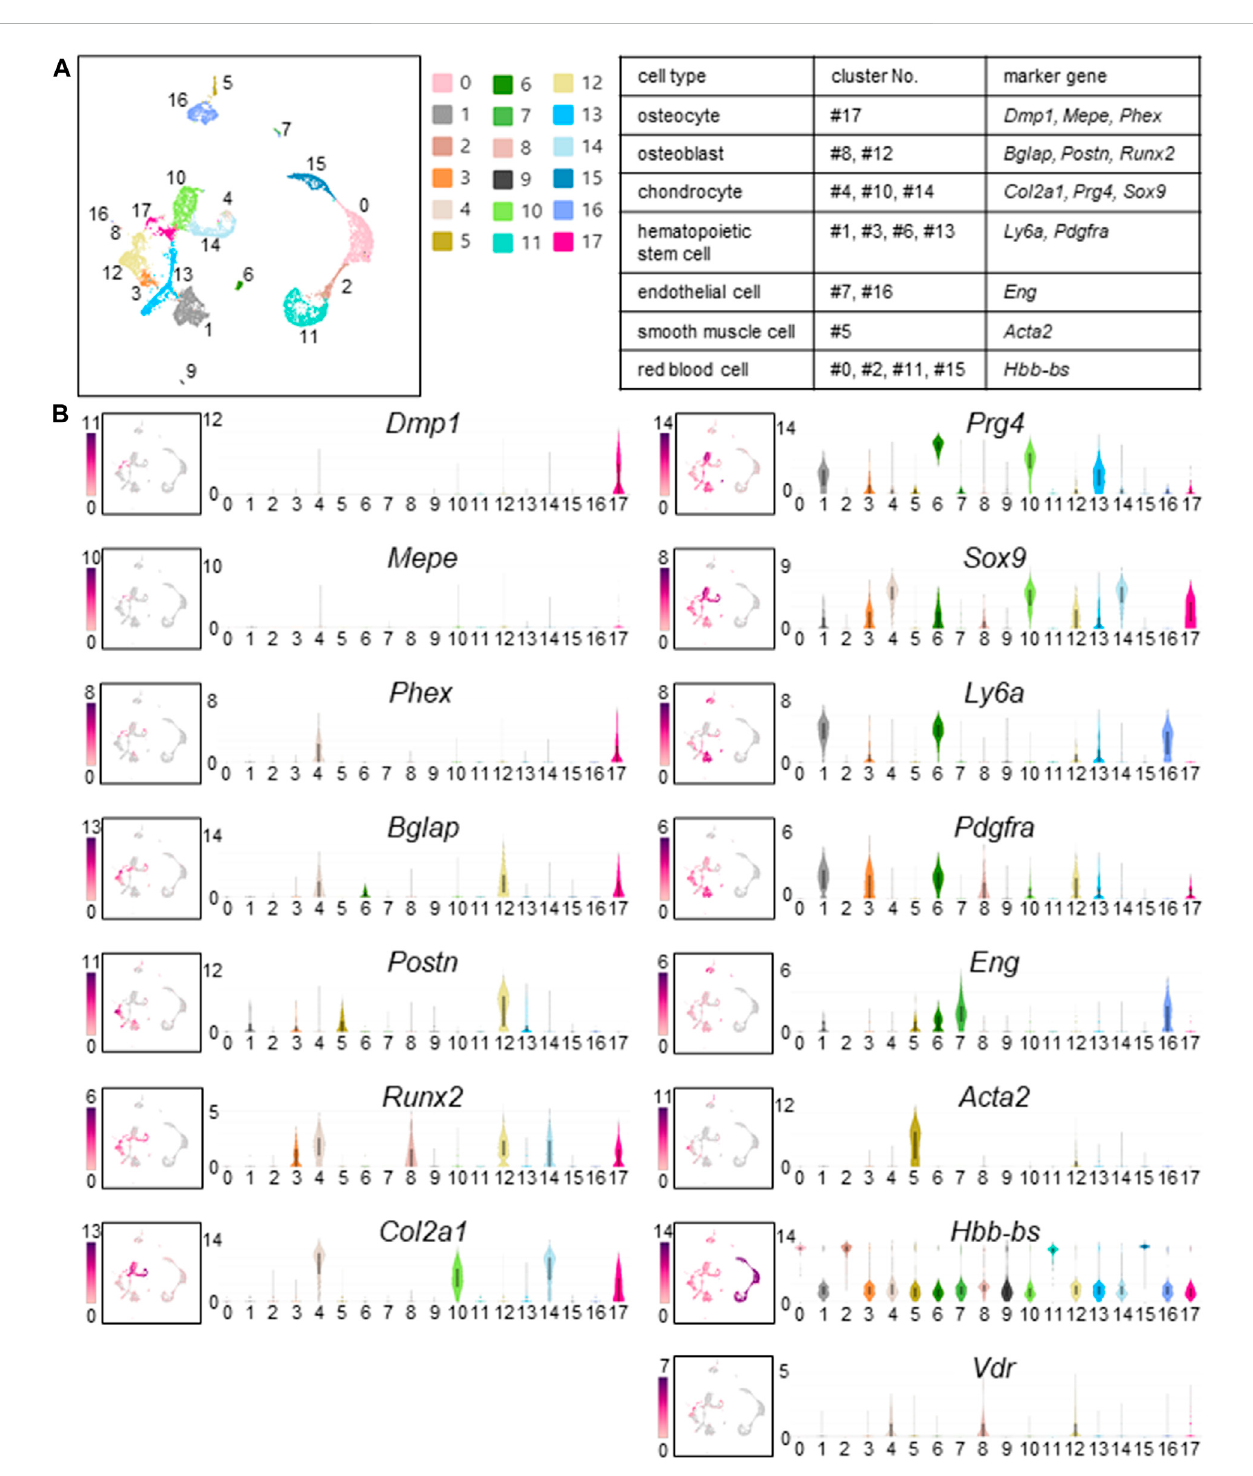
FIGURE 3 Cellclustersidenti fi edinfreshcellsisolatedfrommurinefemurs. (A) Cellclusteringwasperformedoncellsisolatedfromfemursofcalcitriol-injectedand untreated C57BL/6J mice. Uniform Manifold Approximation and Projection (UMAP) plot wherein each dot represents a single cell, and cells sharing the same color code indicate discrete populations of transcriptionally similar cells. Table shows the correspondence between cell type, cluster number, and marker gene when identi fi ed. (B) UMAP plots of gene expression (left) and associated violin plots (right) indicate cluster-speci fi c expression of representative genes. Osteocytes are marked by expression of Dmp1 , Mepe , and Phex (#17). Similarly, osteoblasts express Bglap , Postn , and Runx2 (#8 and #12). Chondrocytes express Col2a1 , Prg4 , and Sox9 (#4, #10, and #14). Hematopoietic stem cells express Ly6a and Pdgfra (#1, #3, #6, and #13). Endothelial cells express Eng (#7 and #16). Smooth muscle cells are distinctly marked by the expression of Acta2 (#5). Red blood cells express Hbb-Bs (#0, #2, #11, and #15). Vdr expression that dictates calcitriol responsiveness is shown by UMAP plot and violin plot. Vdr was expressed in osteoblasts, chondrocytes and osteocytes (#4, #8, #12, and